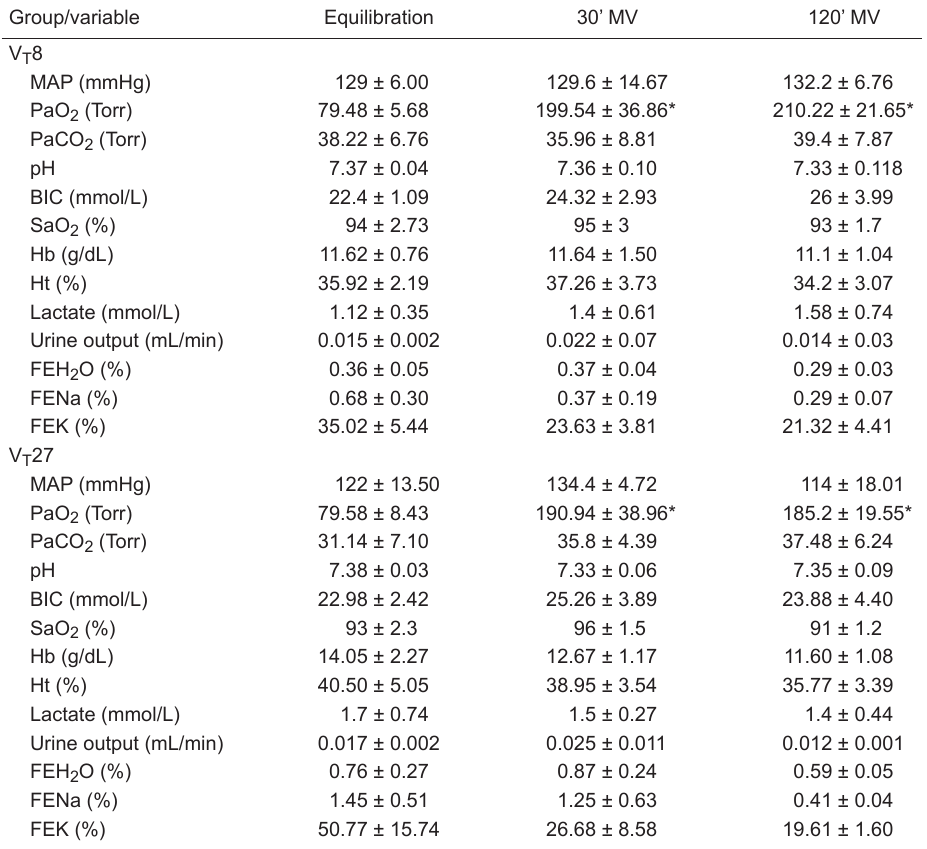
Table 1. Changes in physiologic variables over 120 min of mechanical ventilation with tidal volume of 8 mL/kg (V T 8) or 27 mL/kg (V T